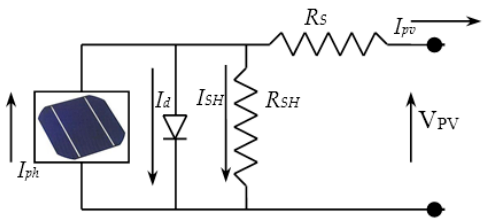
Figure 1. The electrical modeling of the photovoltaic (PV) cell.